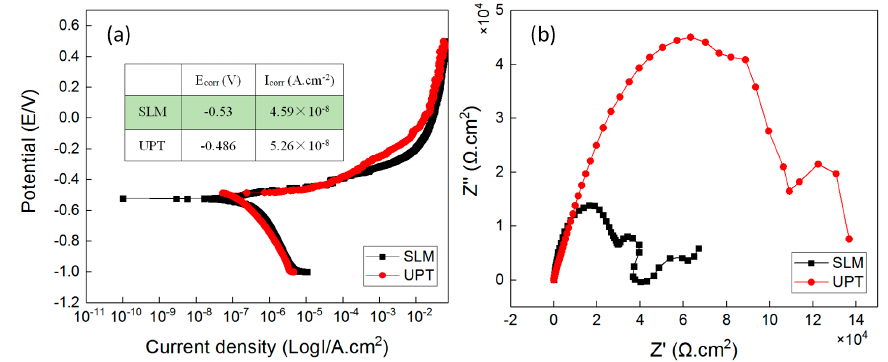
Figure 7. Stress Corrosion Properties of AlSi10Mg Aluminum Alloy ( a ) Polarization curve; ( b ) EIS Nyquist.